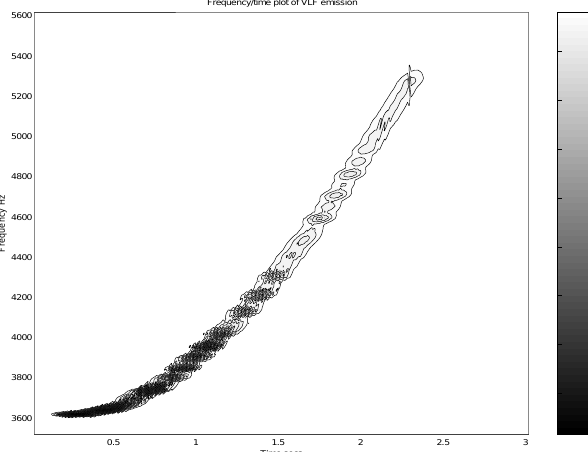
Fig. 2. Frequency-time spectrogram of the stable riser at the exit of the simulation box corresponding to the “base-case”. The units of spectral power are arbitrary in all the spectrograms.